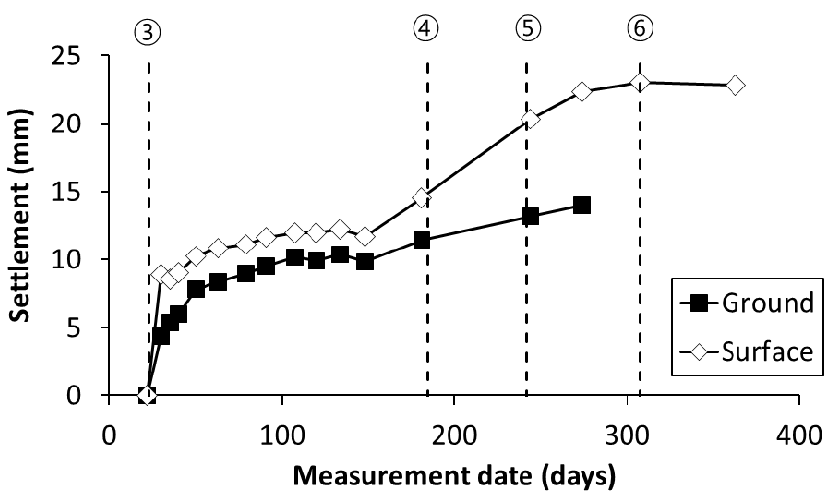
Figure 7. Settlements of RSR over time.